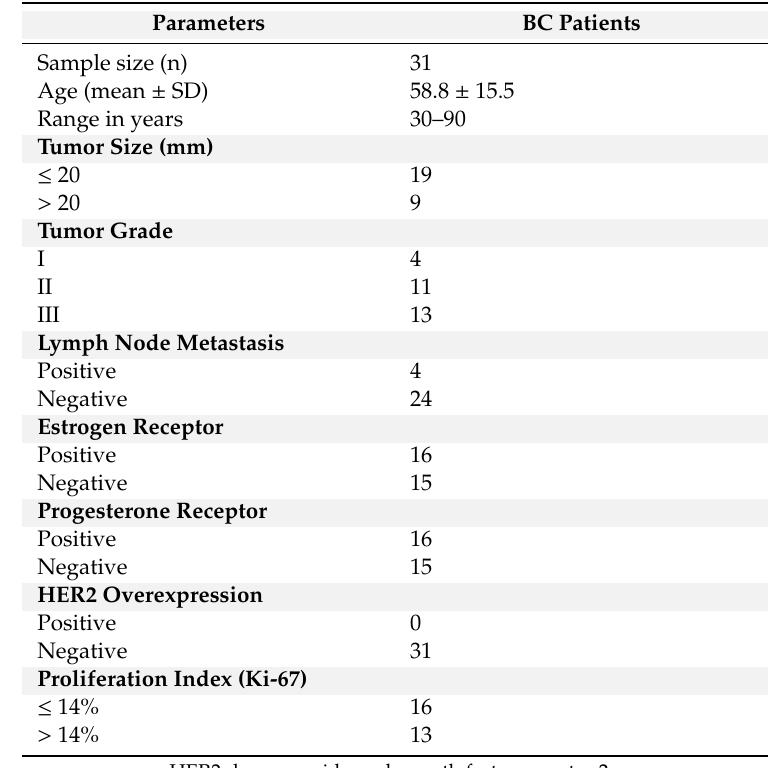
Table 1. Clinicopathological parameters of breast cancer (BC) patients